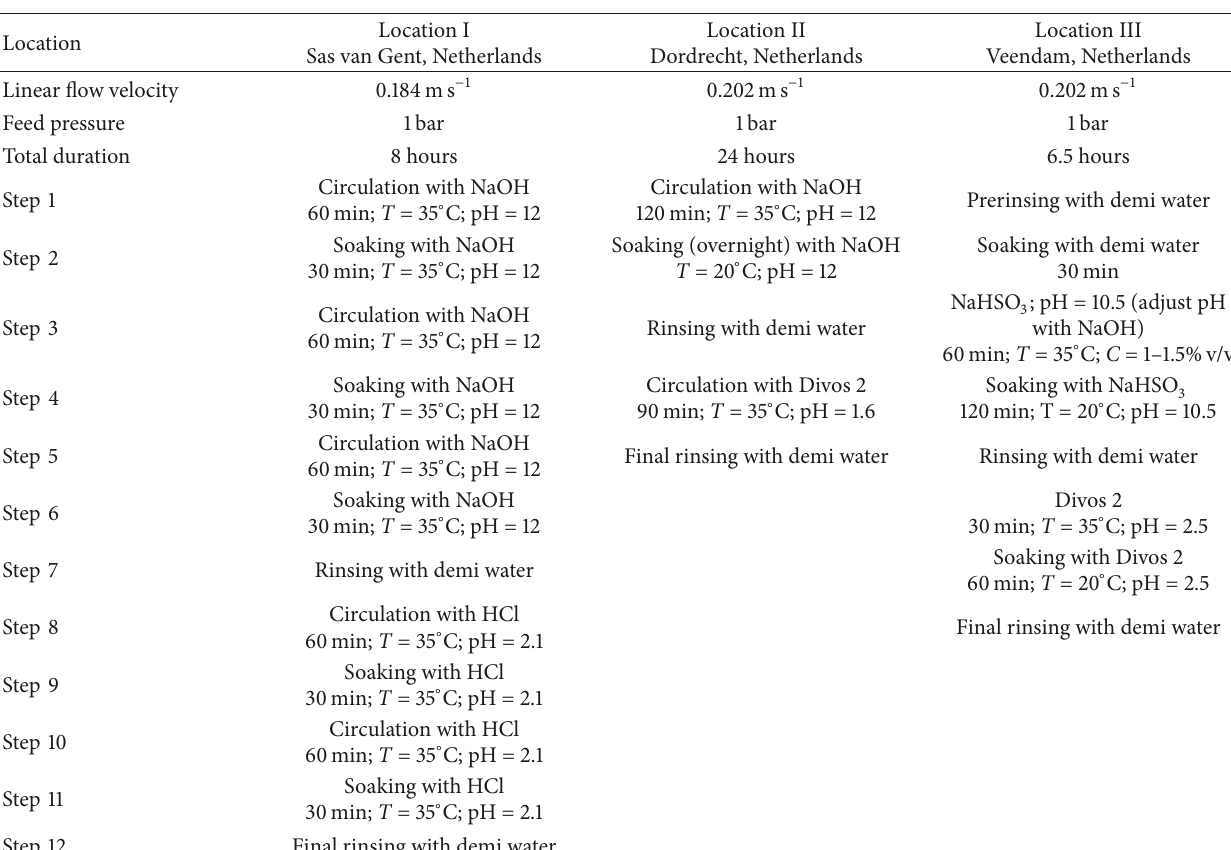
Table 2: Chemical cleaning in place (CIP) procedures applied at the three locations